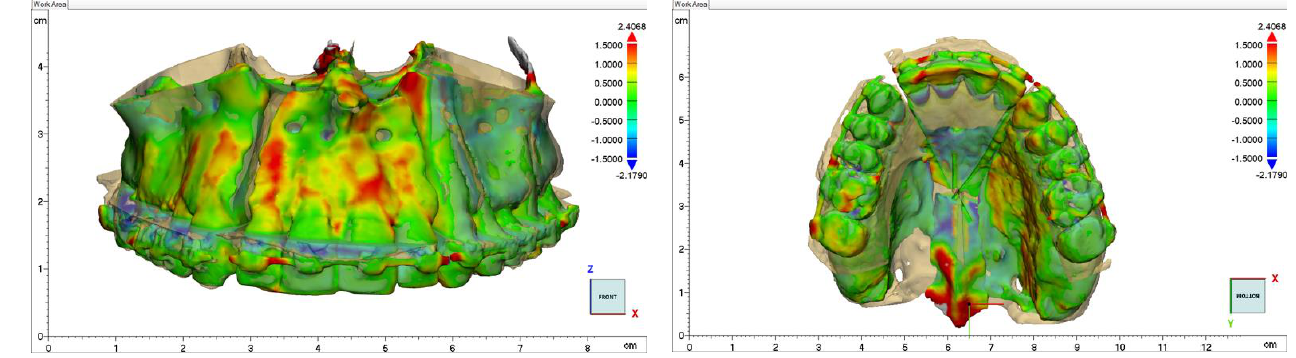
Figure 4. Focus on maxillary discrepancies with color-coded isovalor modifications obtained by superimposing postoperative CBCT with virtually planned postoperative maxilla. The scale is in millimeters.